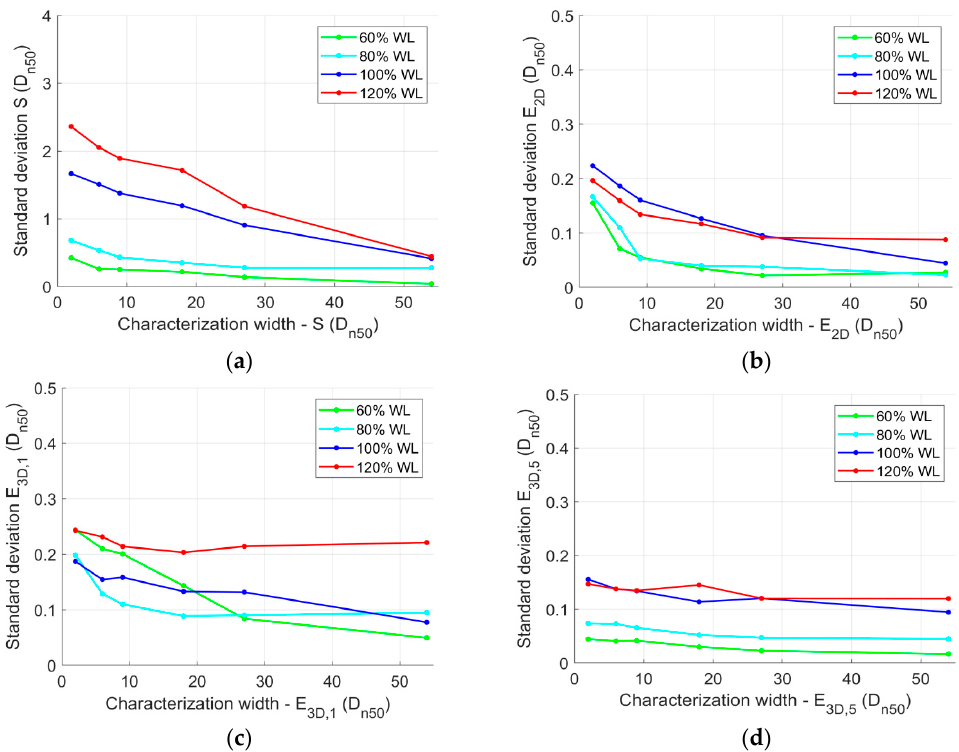
Figure 8. Standard deviations of the damage values versus characterisation width, i.e., the width over which the damage is determined (for Series S1). ( a ) S ; ( b ) E 2D ; ( c ) E 3D,1 ; ( d ) E 3D,5 .